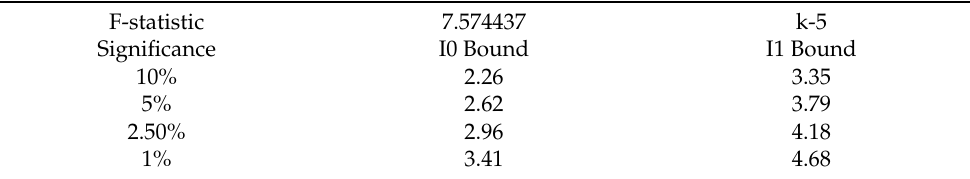
Table 3. ARDL Bounds Test